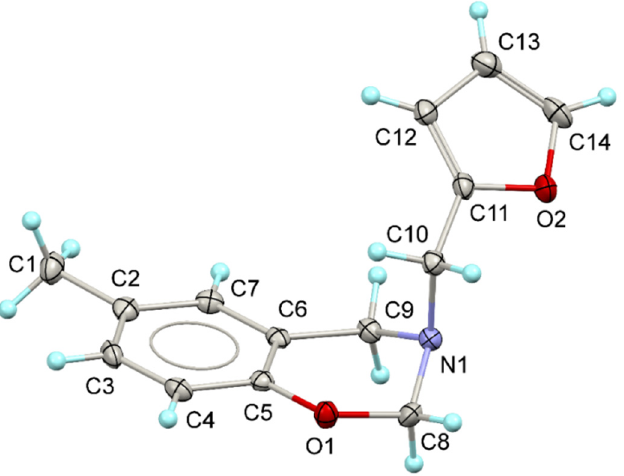
Figure 1. Molecular structures and non-IUPAC labeling scheme of the benzoxazine (I) with displacement ellipsoids drawn at the 50% probability level.